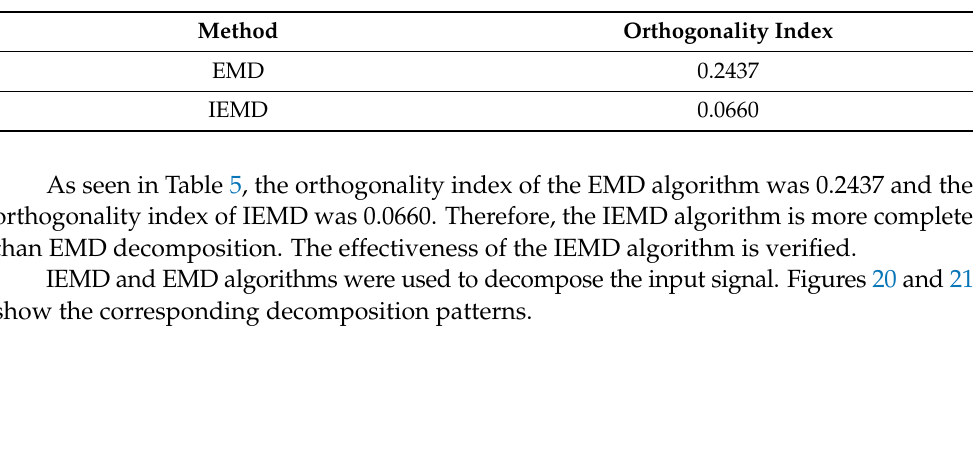
Figure 19. The waveform of intercept signal. Table 5. Coefficients under different decomposition. Table 5. Coefficients under different